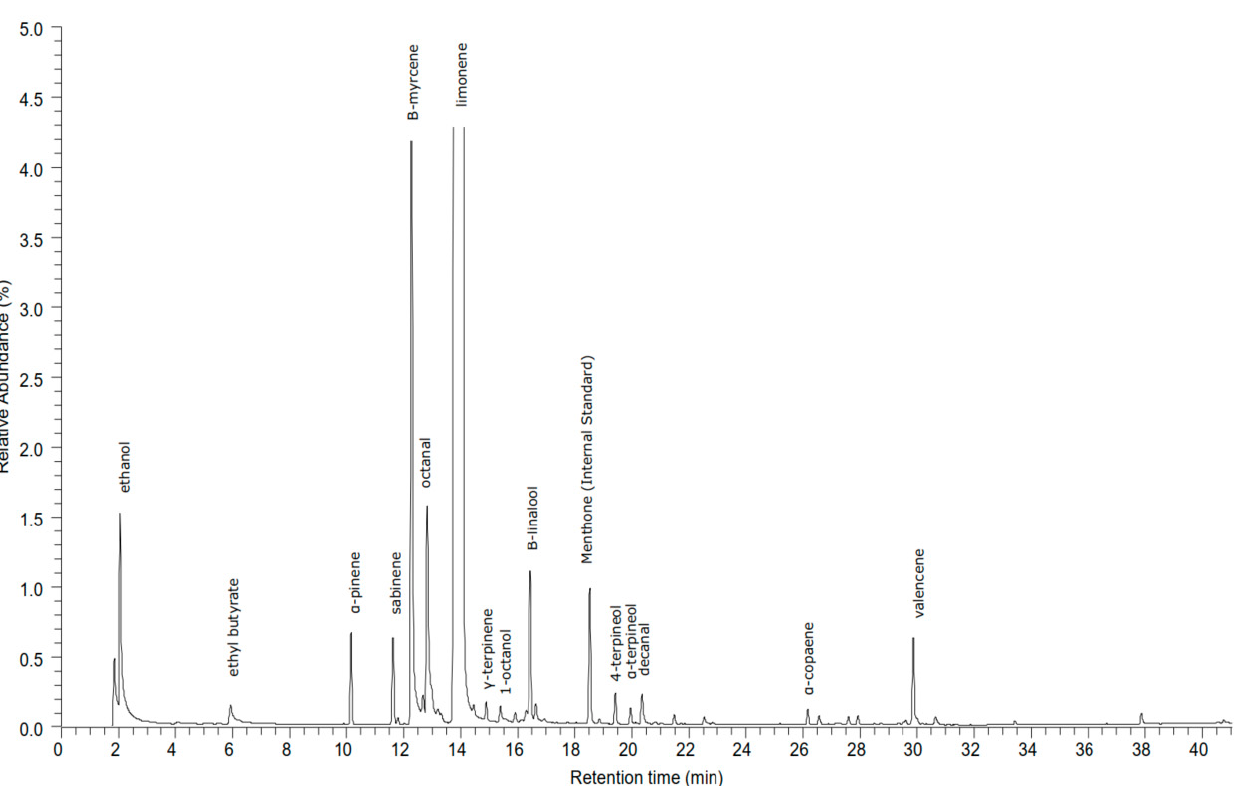
Figure 5. Typical GC-MS chromatogram of orange juice flavor compounds.